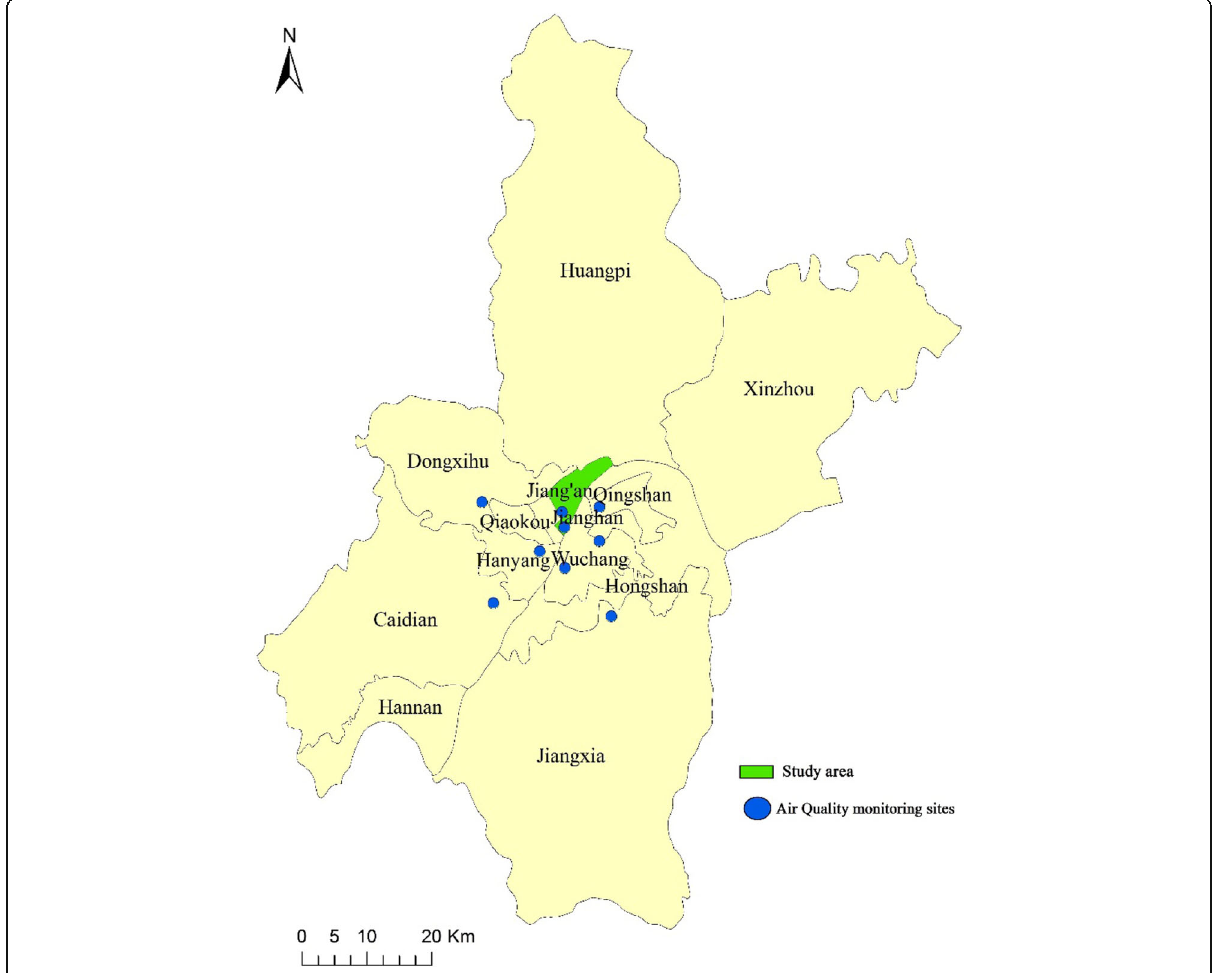
Fig. 1 District map of Wuhan with monitoring station locations. Jiang ’ an District were included in the present